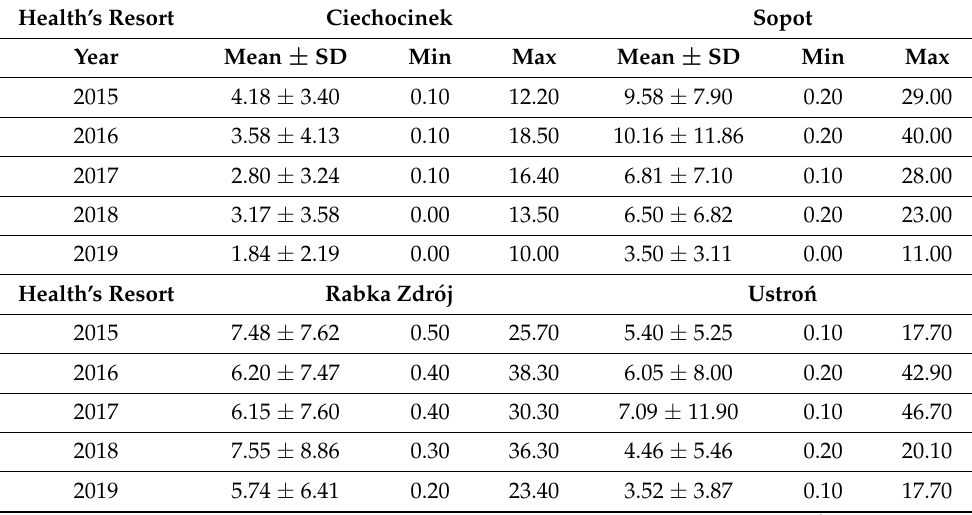
the temperature dropped by about 1 C, and in 2018, there was an increase in the average annual air temperature. Table 5. Average annual values of B (a) P in PM 10 in the studied health resorts in 2015–2019. Health’s Resort Ciechocinek Sopot